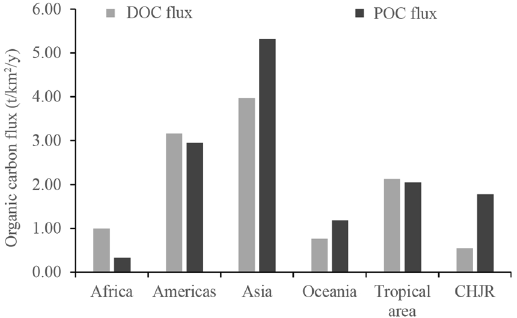
Figure 9. The organic carbon fluxes comparison between CHJR and other tropical rivers 7